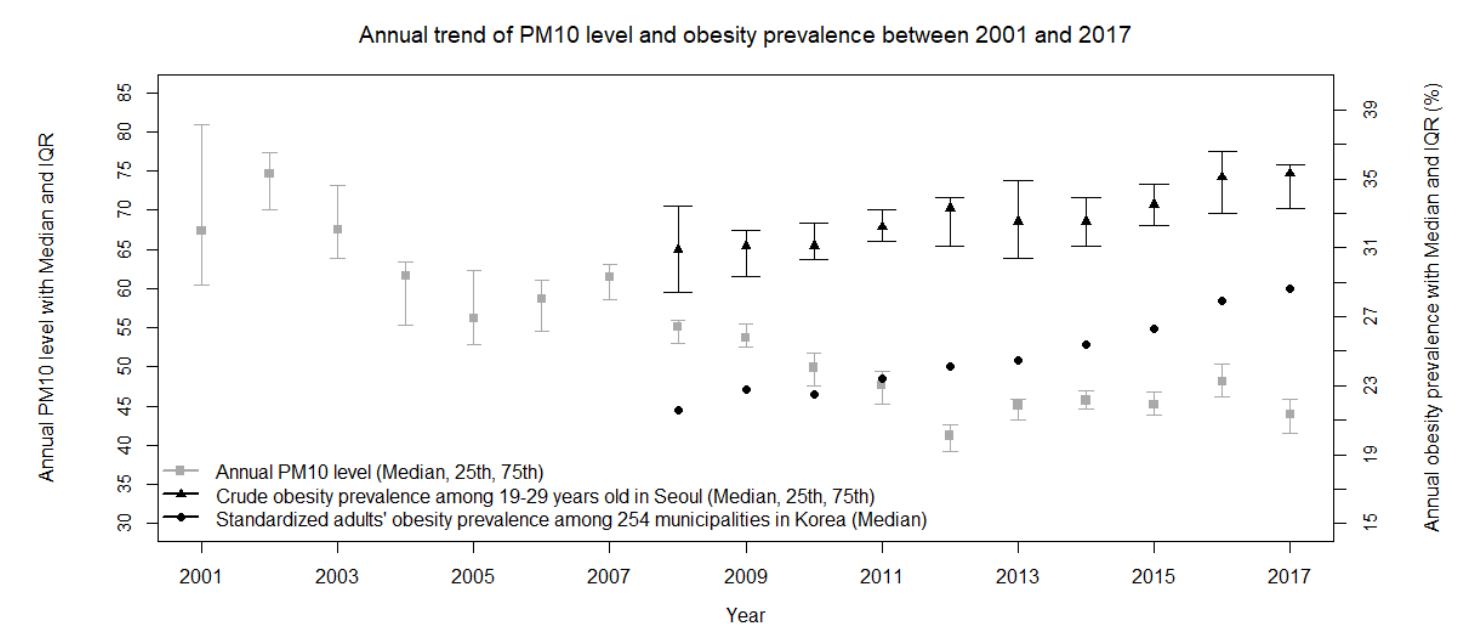
Figure 2. Annual trend of particulate matter (PM 10 ( µ g / m 3 )) levels and obesity prevalence, annual level of PM 10 was calibrated using hourly measured level of PM 10 among 25 municipalities in Seoul between 2001 and 2017 and presented as median value with 25th and 75th . Crude obesity prevalence among study populations aged between 19 and 29 years old in Seoul was presented as a form of median with 25th and 75th. Standardized obesity prevalence among adults aged equal or greater than 19 years old was presented as a form of median and this information was derived from Statistics of Community Health Survey, 2008–2017, published by the Center for Disease Control and Prevention.